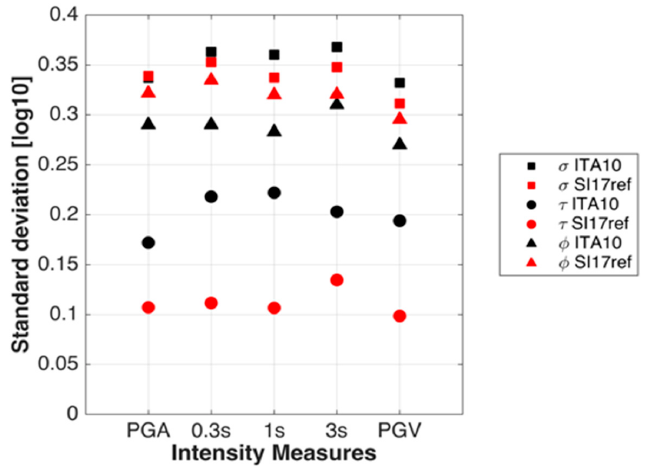
Figure 16. Standard deviations of SI17ref and ITA10. σ , τ , and φ are the standard deviations of the total, between-event, and within-event residuals, respectively.